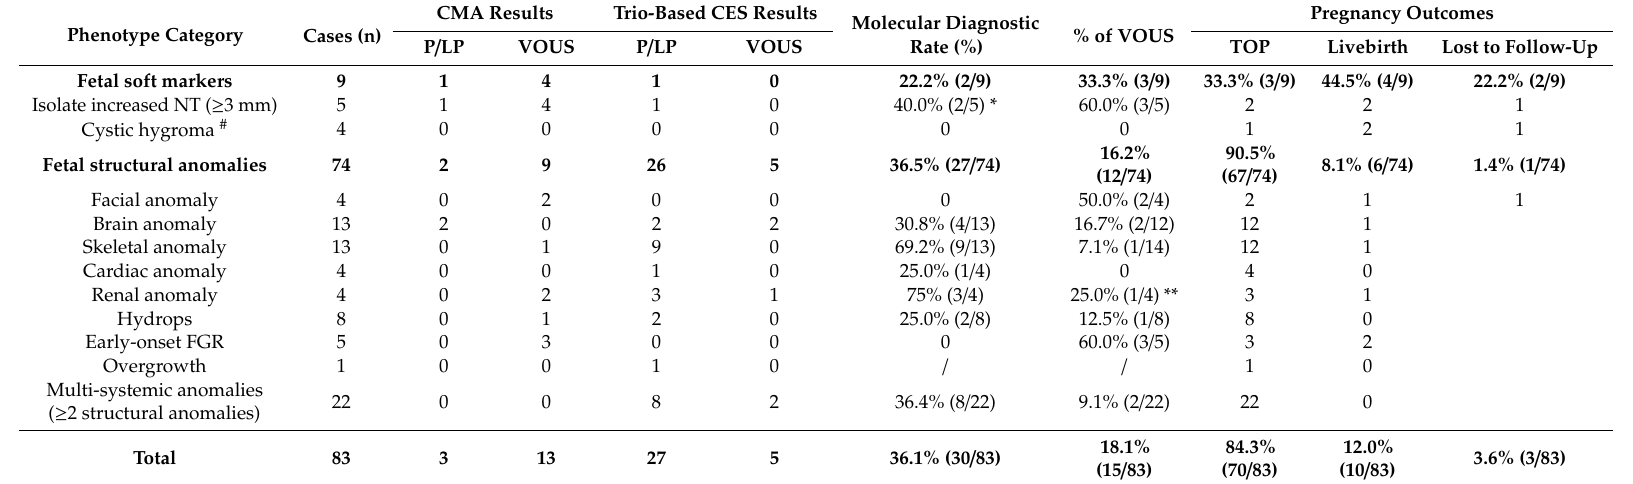
Table 1. Classification of fetal ultrasound anomalies, molecular diagnostic rate and pregnancy